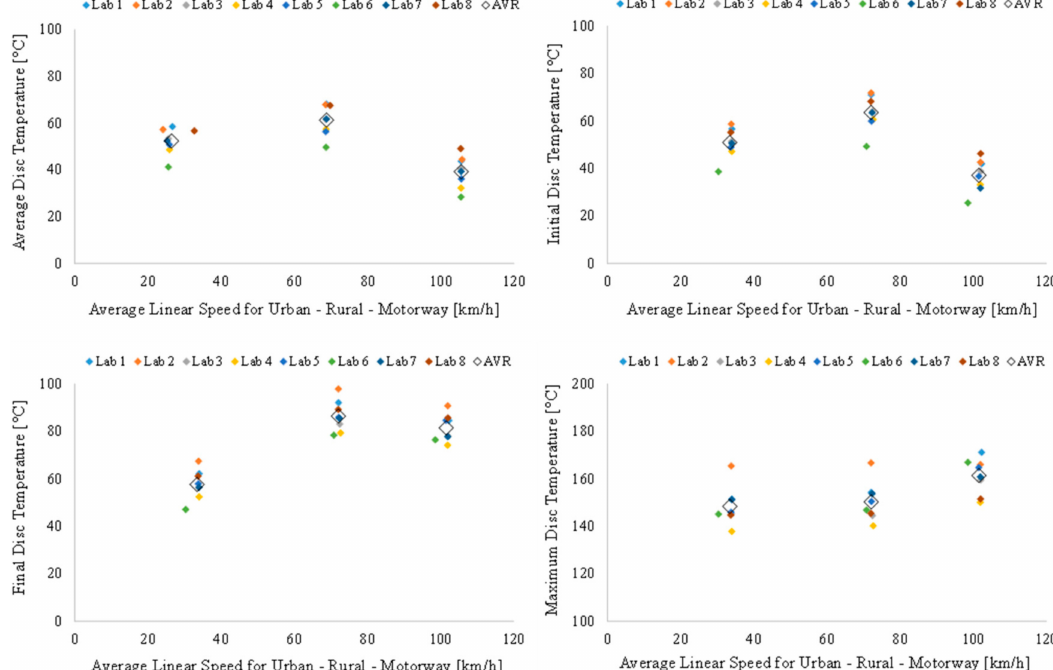
Figure5. Average, initial, final, andmaximumdisctemperatureforalllabsaturban, rural, andmotorway conditions over the R1 of T1—data includes time-resolved temperature extracted at 1 Hz from the EED files for the entire WLTP Brake